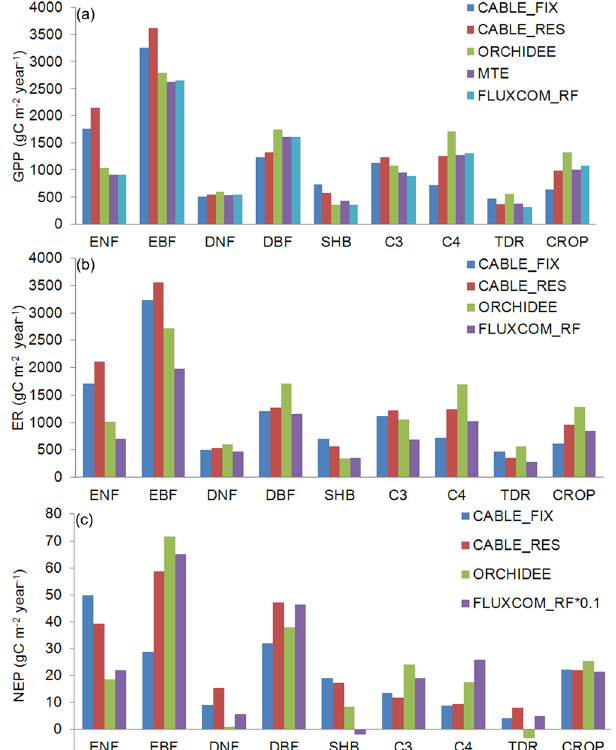
Figure 6. The estimated mean ( a ) gross primary production (GPP), ( b ) ecosystem respiration (ER) and ( c ) net ecosystem productivity (NEP) for different plant functional types by CABLE for the FIX (CABLE_FIX) and RES (CABLE_RES) simulations, ORCHIDEE model in the Trendy project (Sitch et al . 28 ; Le Quéré et al . 29 ), and random forests method in the FLUXCOM global carbon flux data set (FLUXCOM_RF) from Jung et al . 32 . The MTE GPP is from Beer et al . 30 and Jung et al . 31 . ENF: evergreen needleleaf forest; EBF: evergreen broadleaf forest; DNF: deciduous needleleaf forest; DBF: deciduous broadleaf forest; SHB: shrub; C3: C3 grass; C4: C4 grass; TDR: tundra; CROP: C3